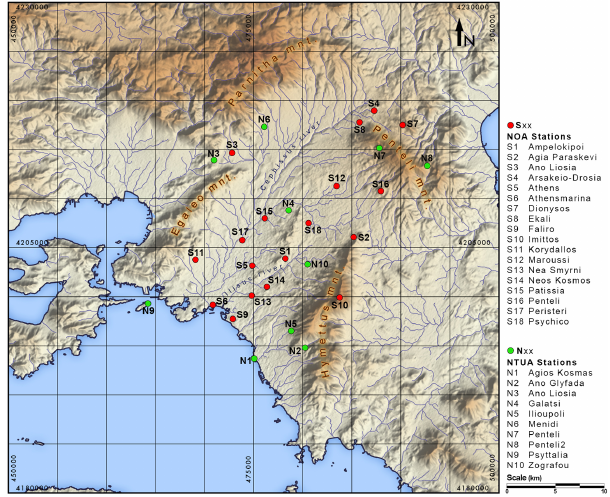
Figure 1. Map of the Greek target area (Athens and suburbs) and locations of the 28 surface meteorological stations. Stations are named by the municipalities they are located in. (Created us- ing QGIS and SRTM-v3 elevation data. Projection GGRS87. Area easting: 450000–500000m. Area northing: 4180000–4230000m. Copyright